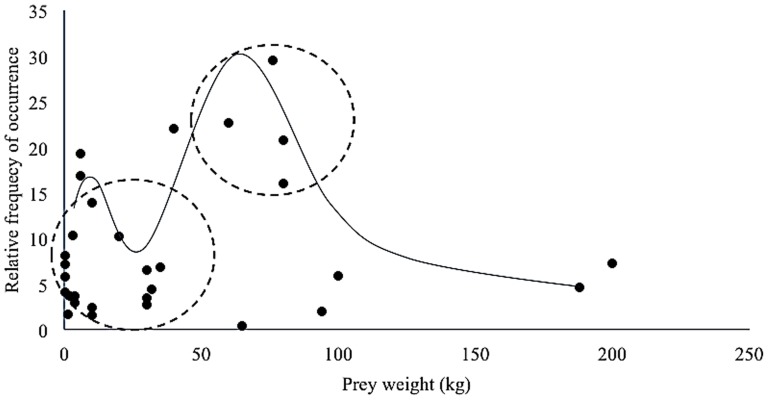
Prey weight and relative occurrence of prey in snow leopard scat.Prey weights used were ¾ the body mass of average adult female of each prey species. Double hump indicates that snow leopard feeds primarily on large prey but may shift to small-bodied prey sub-optimally.